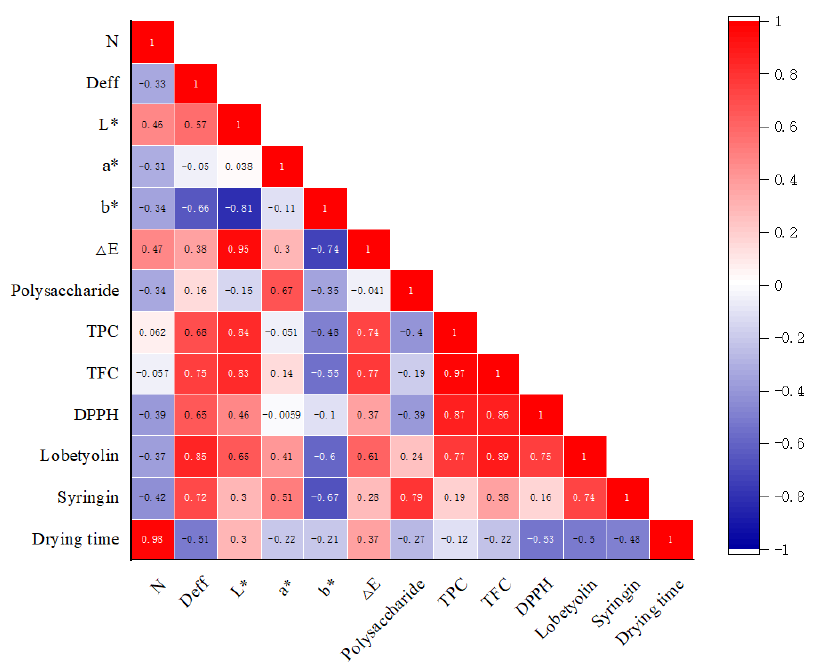
Figure 4. Pearson correlation analysis of Codonopsis pilosulae after different drying